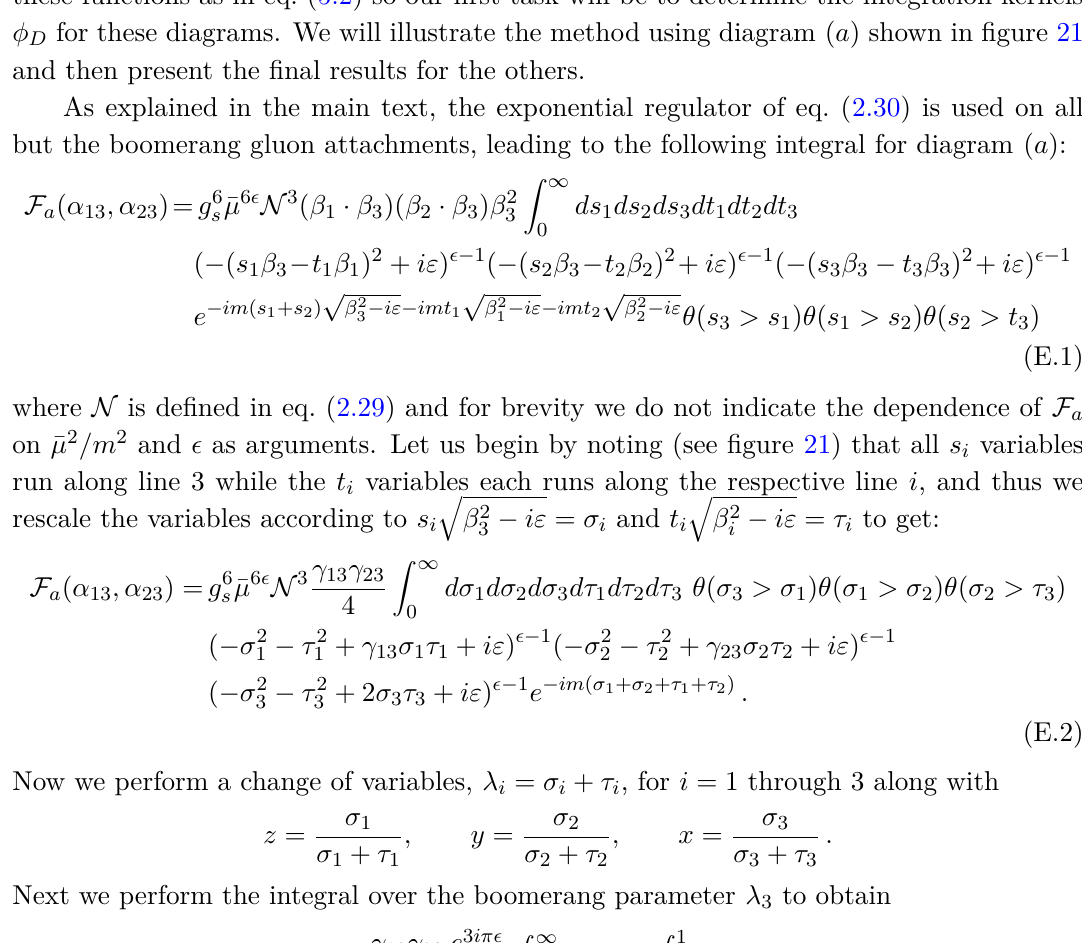
and t for i = 1 to 3 i i